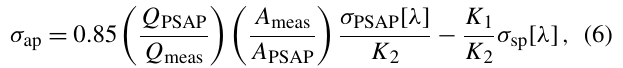
Table 2. List and specifications of optical instrumentation and applied correction algorithms. Instrument Manufacturer Property λ (nm) Aerosol Correction algorithm CAPS PM SSA Aerodyne Research, Inc. σ sp , σ ep 630 AS, AD, BC, MIX Mie Amigo (Aerodyne Research, Inc.) for σ sp truncation correction (Onasch et al., 2015) CAPS PM ex Aerodyne Research, Inc. σ ep 630 AS, AD, BC, MIX No correction required NEPH TSI Inc. σ sp 450, 550, 700 AS, AD, BC, MIX Müller et al. (2009), Anderson et al. (1998), Massoli et al. (2009) PSAP Radiance Research Inc. σ ap 467, 530, 660 AS, AD, BC, MIX Ogren (2010), Virkkula (2010)